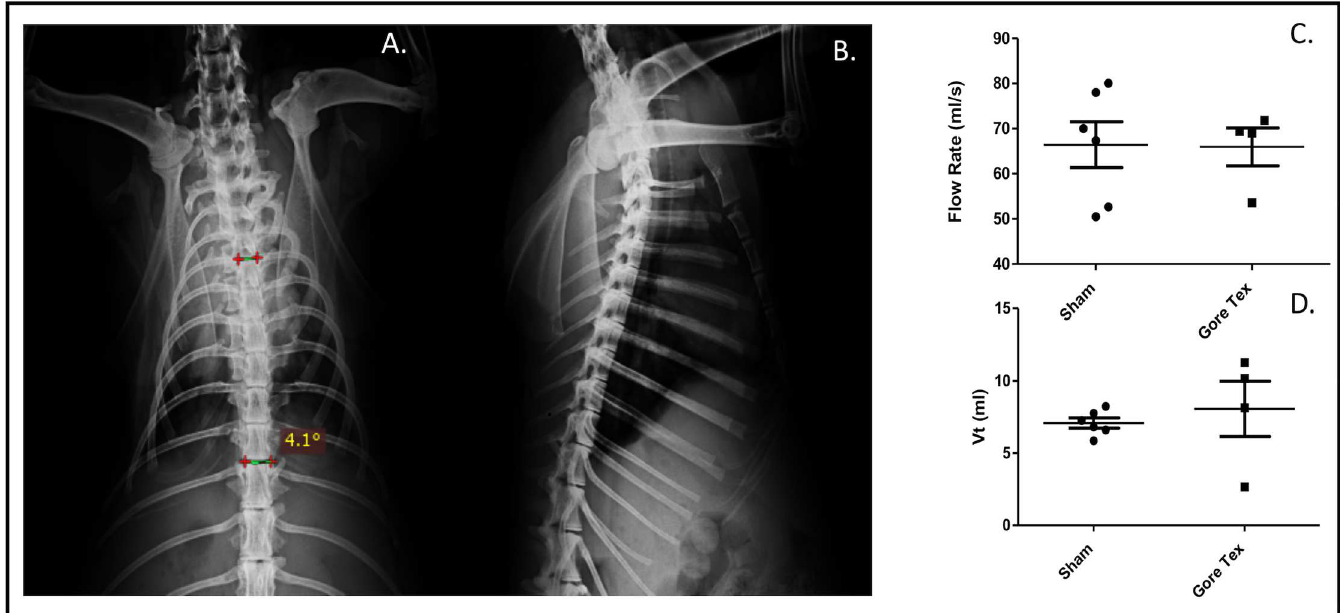
Fig 4. Pulmonary Outcomes. Chest X-Ray (CXR) showingA. Cobb angle measurement (PA film) B. lateral view in sham operatedanimalsand pulmonary function testing showingC. Flow rate, d. Tidal volume.